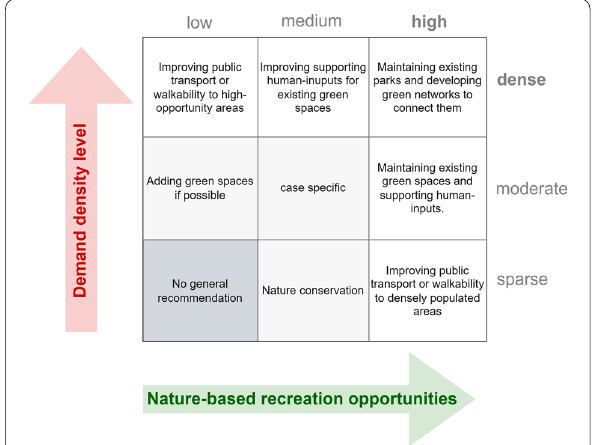
Fig. 10 General planning recommendations based on the relationship between NBR opportunities and demand density level. The recommendations are based on the cross-tabulation of different levels of demand density and NBR